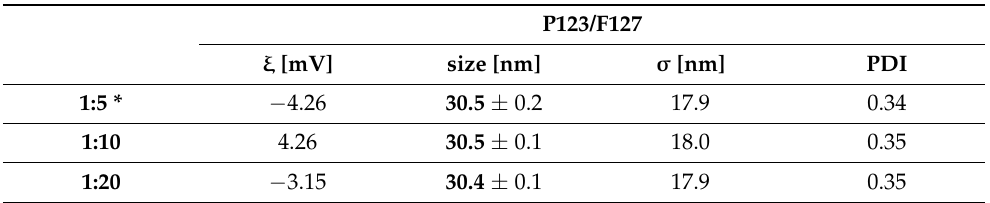
Table 4. Size of the xanthohumol-loaded polymeric micelles dissolved in water. ξ —Zeta potential, σ —standard deviation, PDI—polydispersity